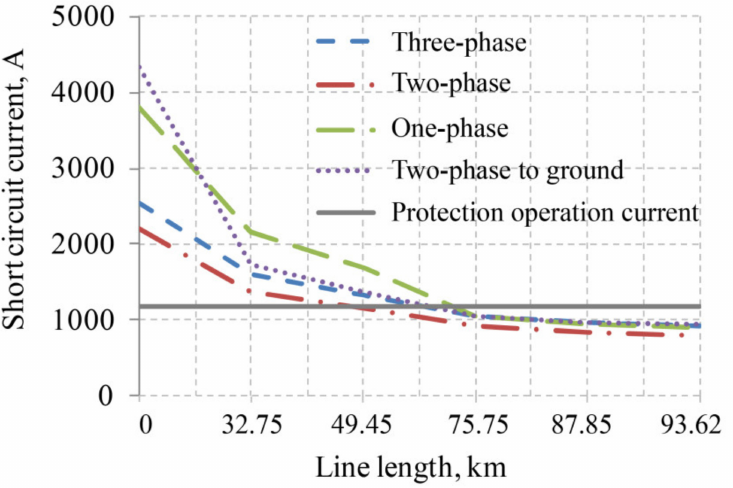
Figure 16. Change in the “dead zone” length for the soil resistance of 20 Ohm · m, the setpoint was calculated according to the traditional OHL